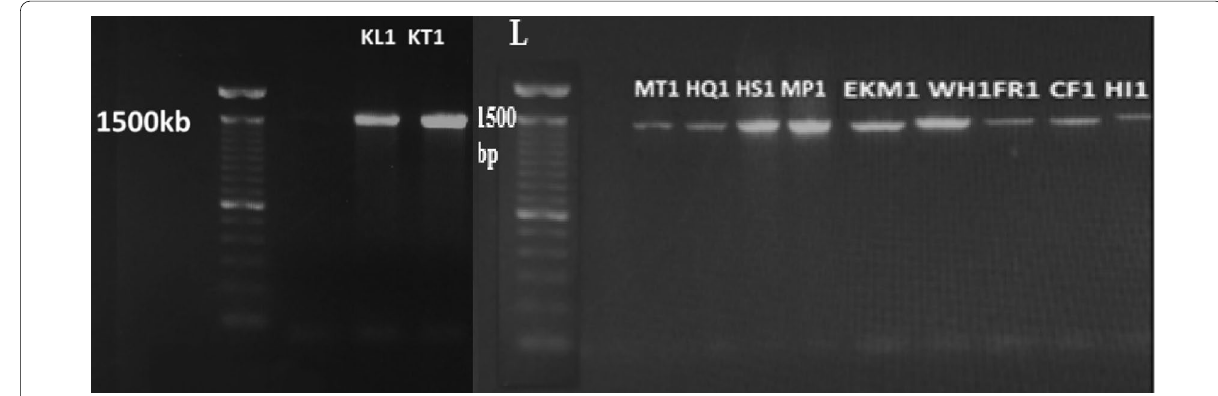
Fig. 2 16S rRNA gene amplified from different isolates (1.5 Kb)